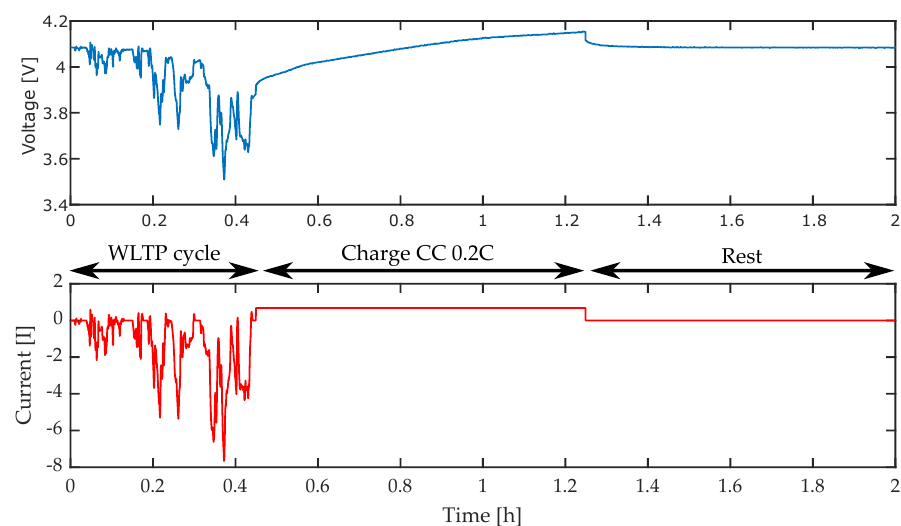
Figure 3. World Harmonized Light-duty Vehicle Test Procedure (WLTP)-based aging cycle. Current profile (red) and voltage response